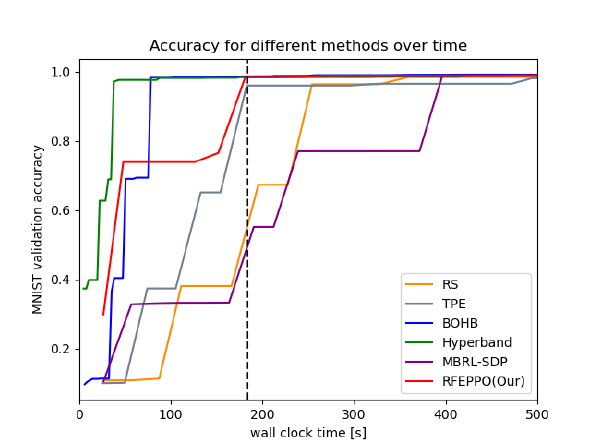
Figure 7. Average validation accuracy across 5 trials on MNIST